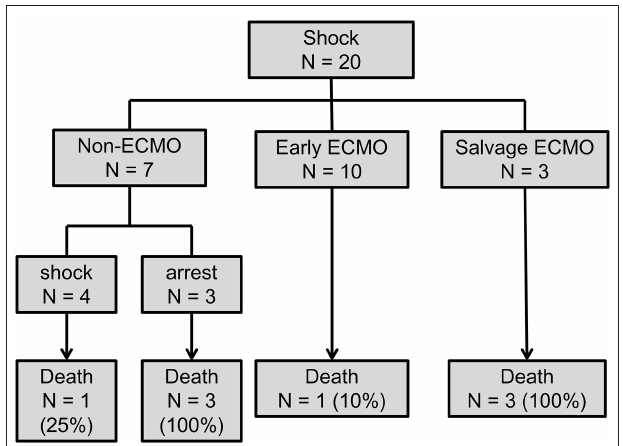
FIGURE 3 | Flow chart of comparing the outcome in patients with and without earlier ECMO treatment. ECMO, veno-arterial extracorporeal membrane oxygenation.